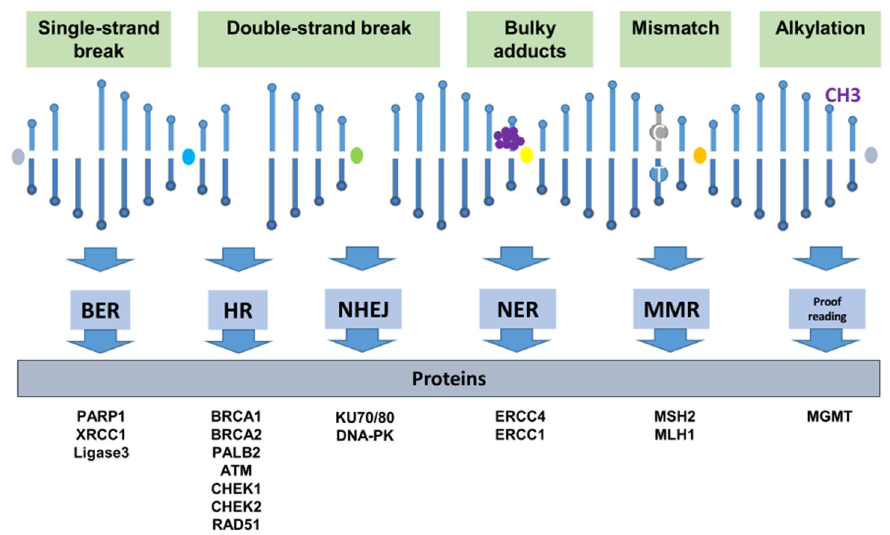
Figure 1. Major types of DNA damage, their according repair mechanisms and proteins involved. BER (Base Excision Repair), HR (Homologous Repair), NHEJ (Non-homologous end joining), NER (Nucleotide Excision Repair), MMR (Mismatch Repair) and proofreading.